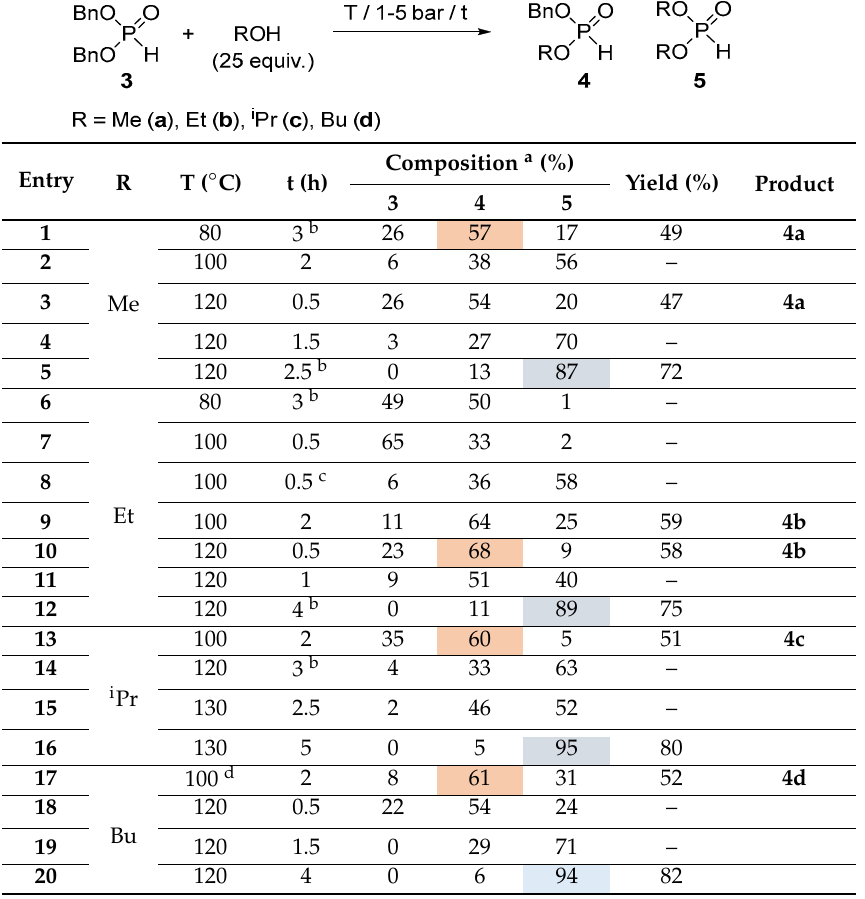
Table 5. Alcoholysis of dibenzyl phosphite ( 3 ) in a batch MW reactor.